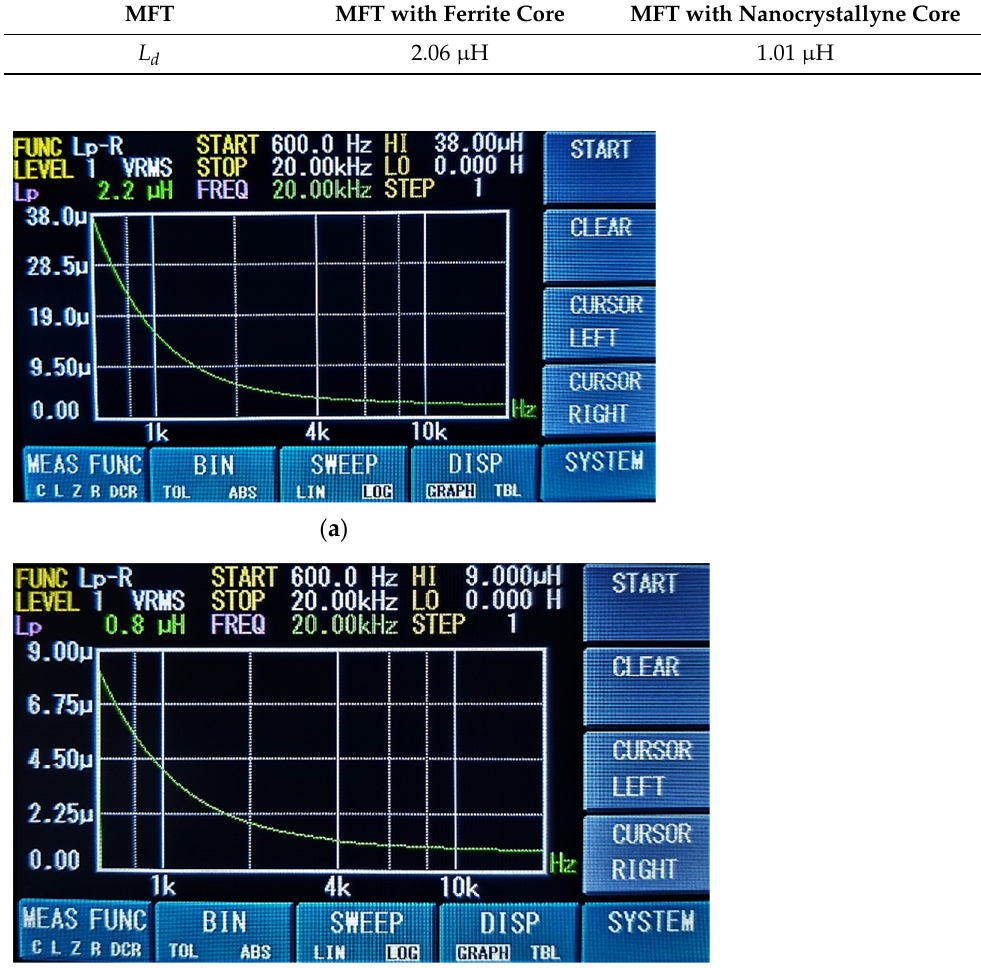
Table 6. Dispersion inductance calculated in both MFTs.